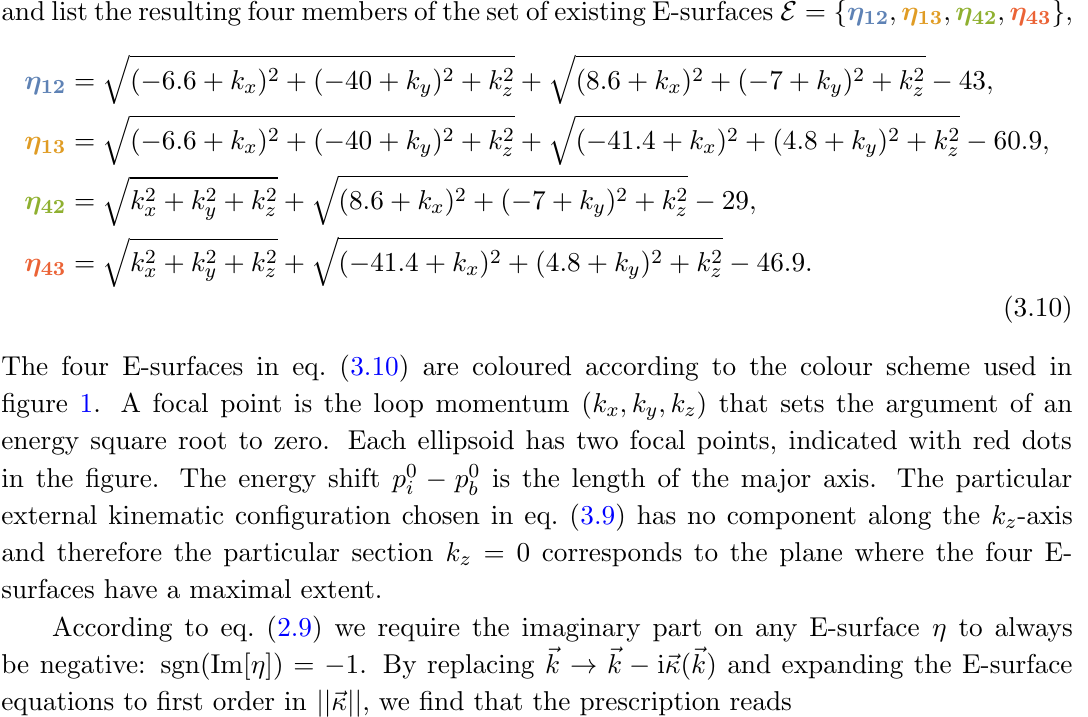
Figure 1. A k z = 0 section of the singular structure of the example con(cid:12)guration four singular E-surfaces with four (partially shared) focal points coloured in